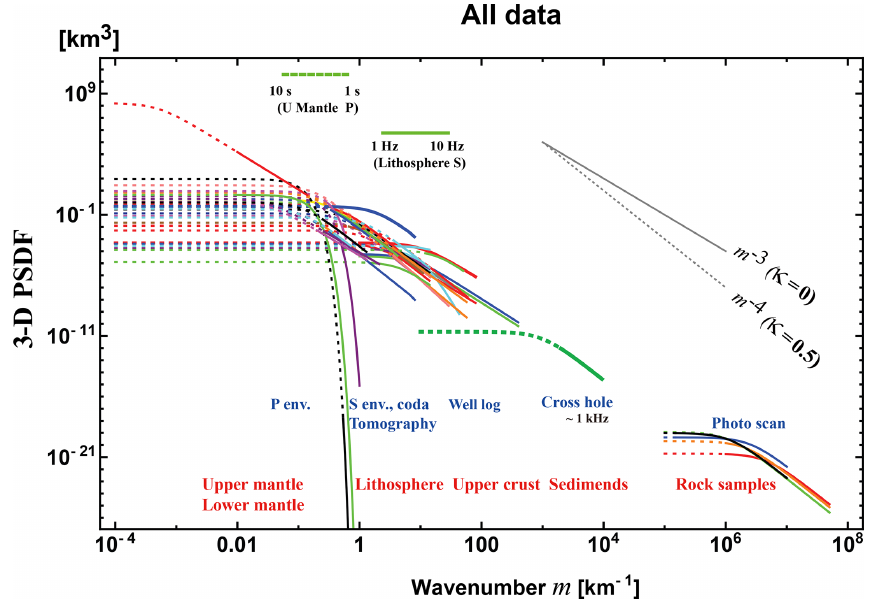
Figure 5. 3-D PSDF vs. wavenumber for all the